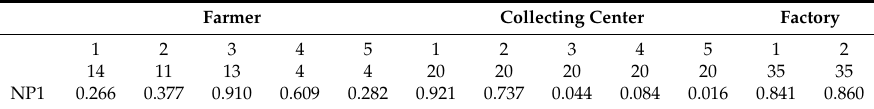
Table 1. Encoding random numbers [0, 1] in each vector.